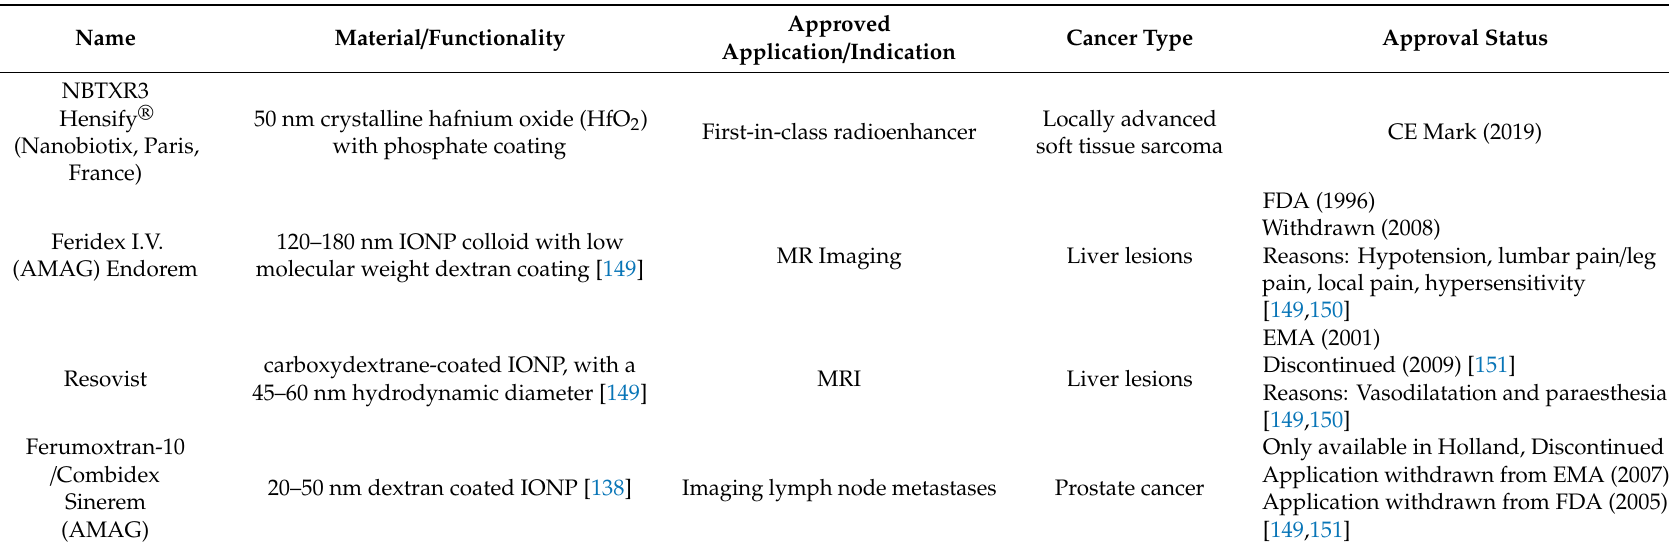
Table 1. Inorganic nanoparticles approved in the